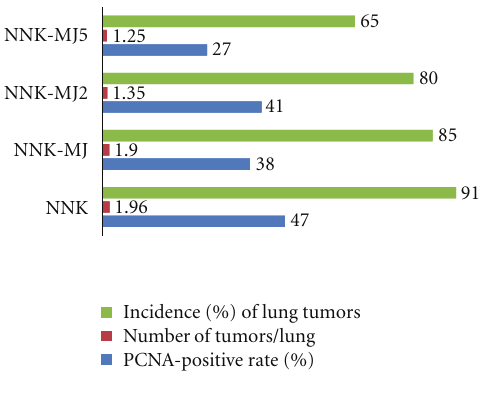
Figure 5: MJs suppress AOM-induced colonic adenocarcinoma (ADCs) in rats.